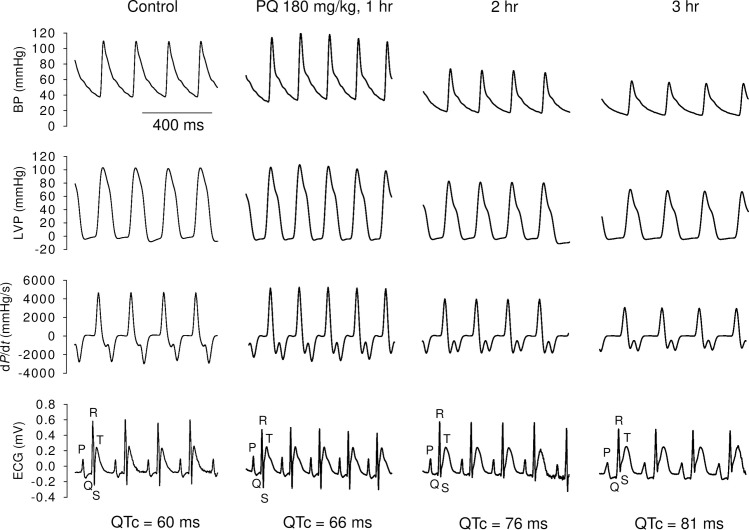
Representative recordings of arterial pressure, LV pressure (LVP), first derivative of LV pressure (LV dP/dt), and ECG from an anesthetized rat at baseline and at various times after PQ treatment (180 mg/kg, i.v.).QTc value in each panel denotes rate-corrected QT interval derived using normalized Bazett’s formula QTc = QT/(RR/f)1/2, where f = 180 ms.